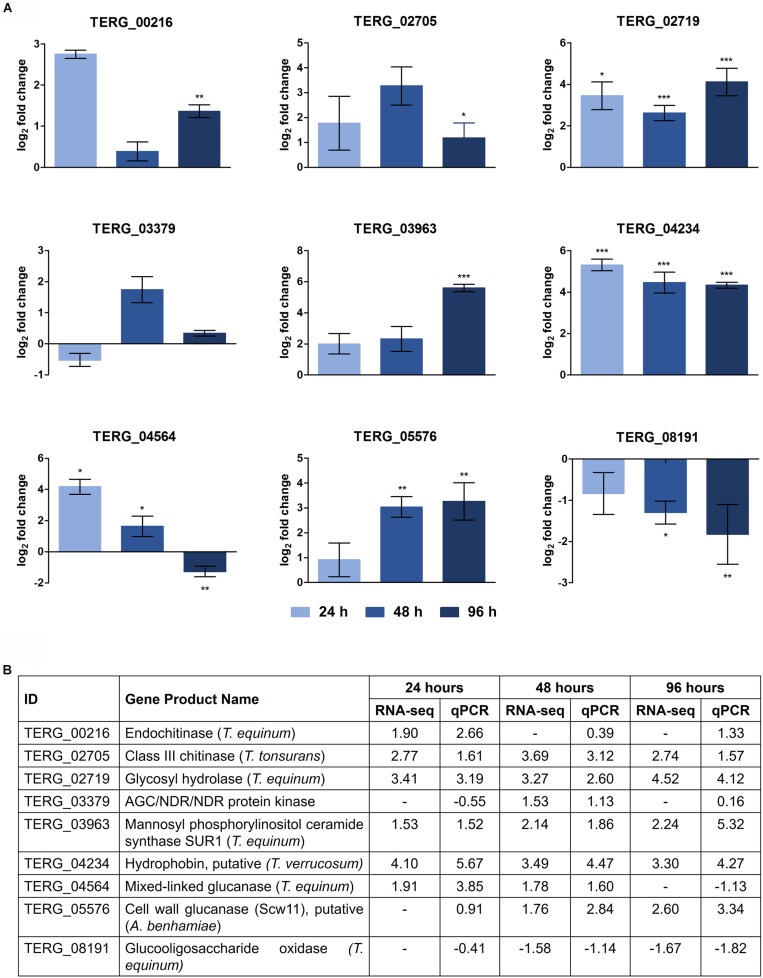
Validation of DEGs under keratin cultivation by qRT-PCR. (A) Gene expression levels are represented as log2-fold changes relative to each control condition (24 h keratin × 24 h glucose; 48 h keratin × 48 h glucose; 96 h keratin × 96 h glucose). Asterisks indicate statistical significance determined by Student’s t-tests comparing treatment and control conditions at each time point (∗P < 0.05; ∗∗P < 0.01; ∗∗∗P < 0.001). (B) Comparison of gene expression levels determined by RNA-seq with those evaluated by qRT-PCR (Pearson’s correlation, r > 0.82; P < 0.001).